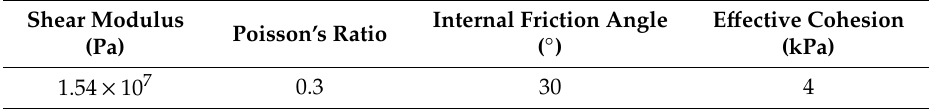
Table 4. Input data of soil in case study.